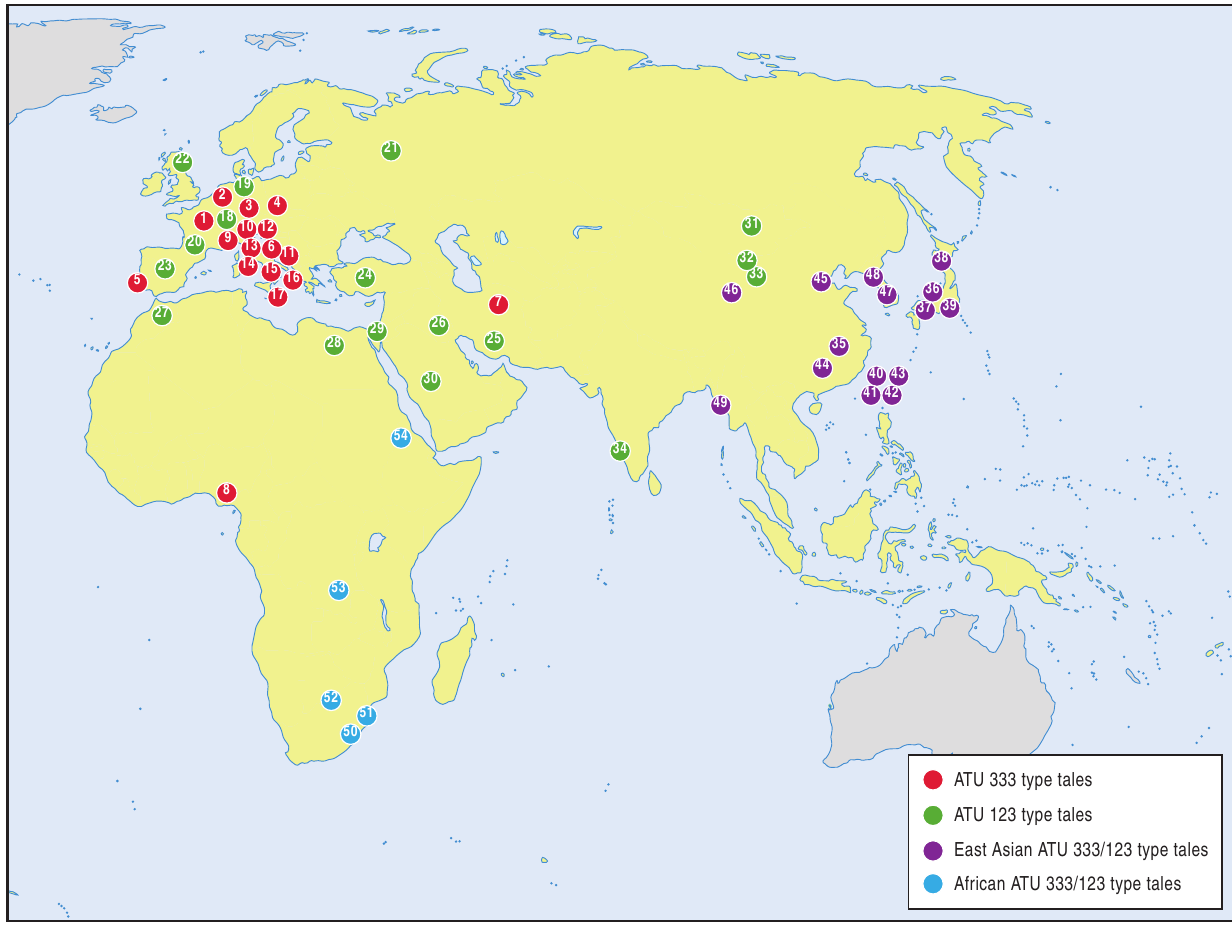
Figure 1. Map of the approximate locations from which tales were sourced. Numbers in the circles refer to the variants listed in the Supporting Information (Table SI.1).